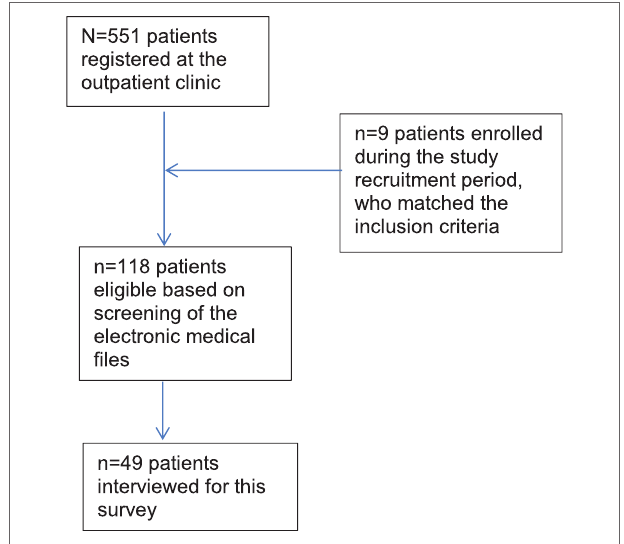
FigUre 1 | Flowchart of patient